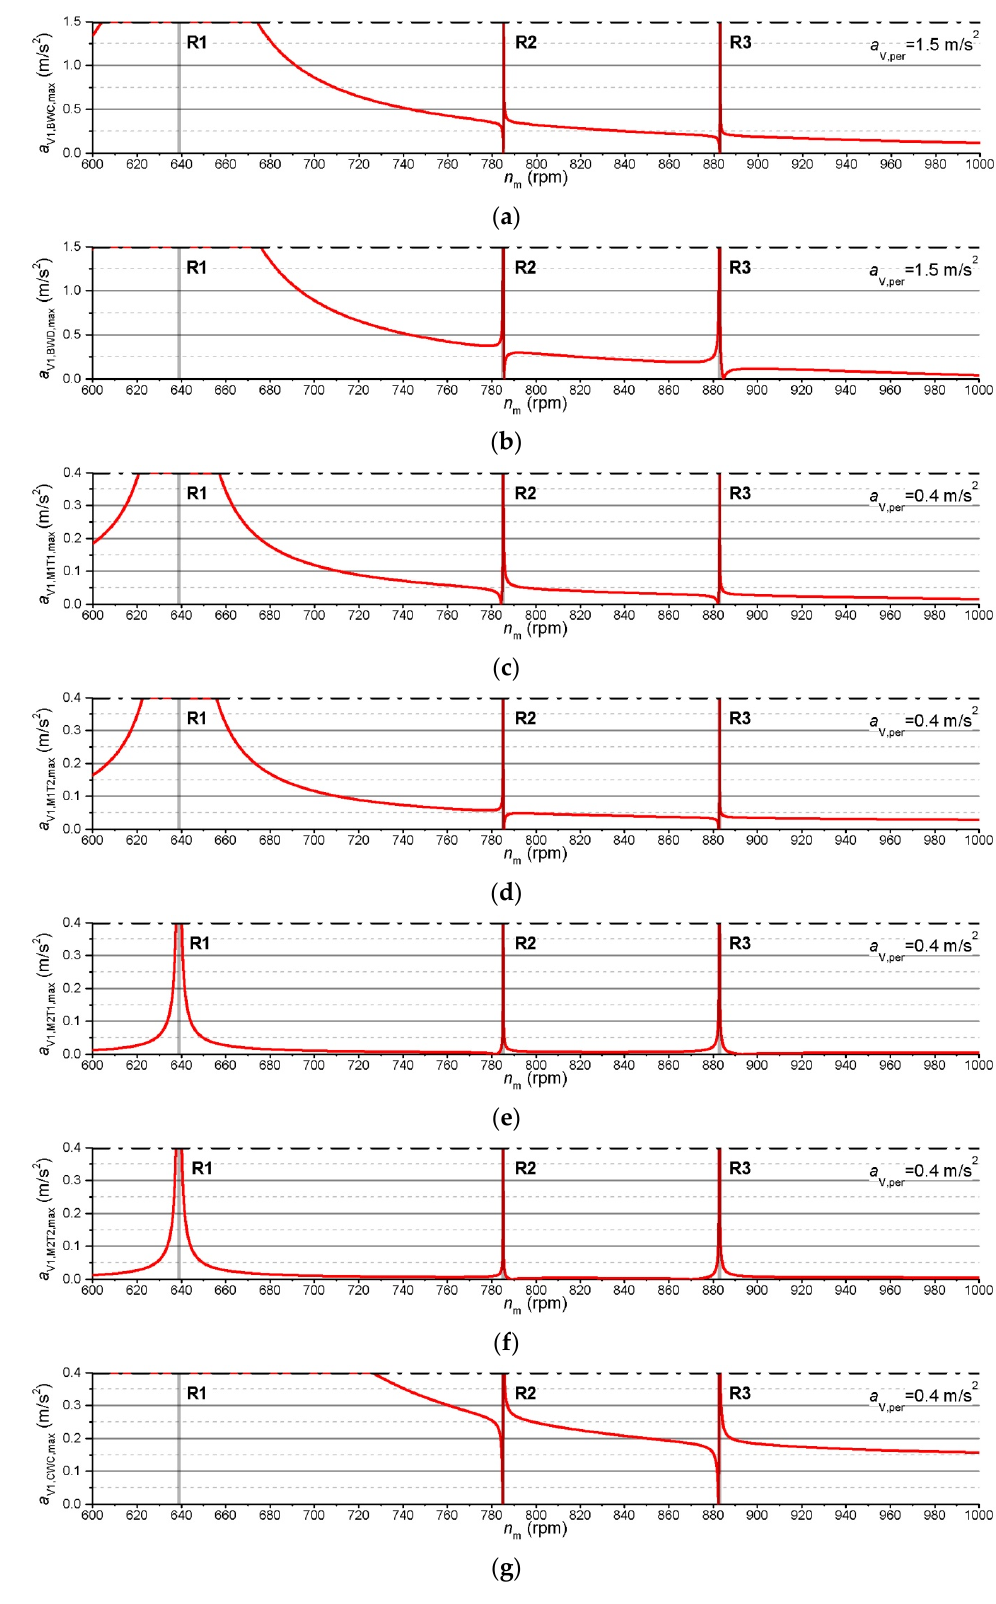
Figure 4. Response to the first harmonic of excitation—maximal vertical accelerations of the referent points of the slewing superstructure: ( a ) BWC; ( b ) BWD; ( c ) M1T1; ( d ) M1T2; ( e ) M2T1; ( f ) M2T2; ( g ) CWC.